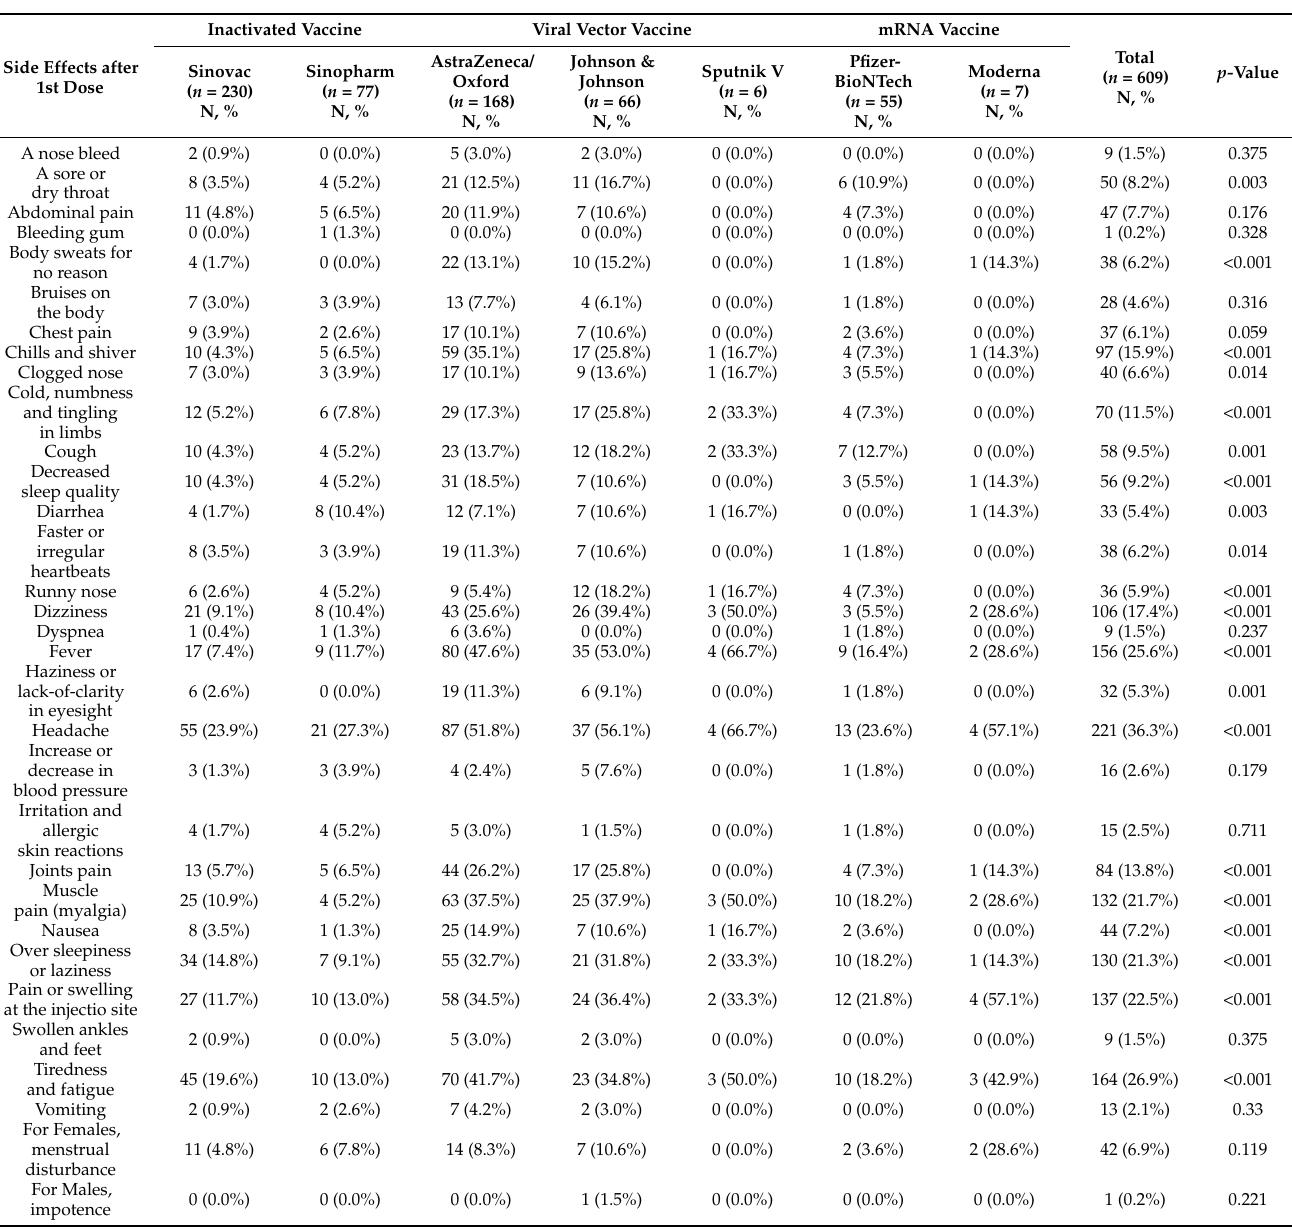
Table 3. COVID-19 vaccine side effects reported by the participants after the first dose of different vaccine types ( n =